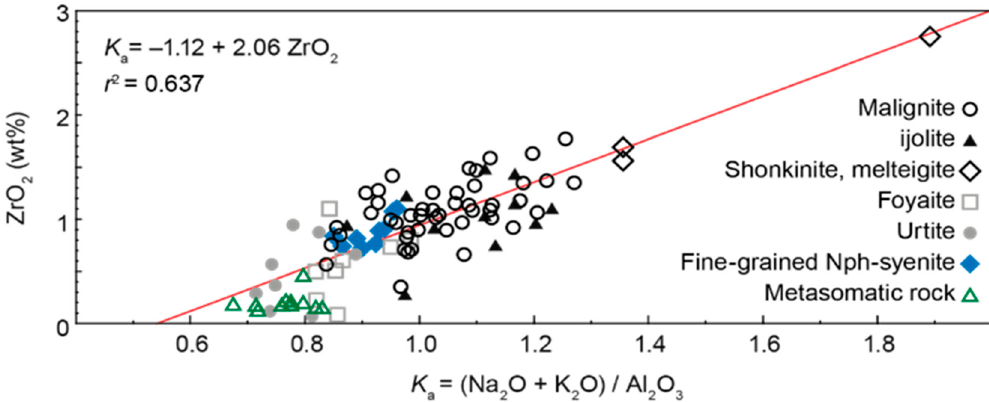
Figure 7. Content of ZrO 2 in rocks as a function of their agpaitic coefficient, K a .